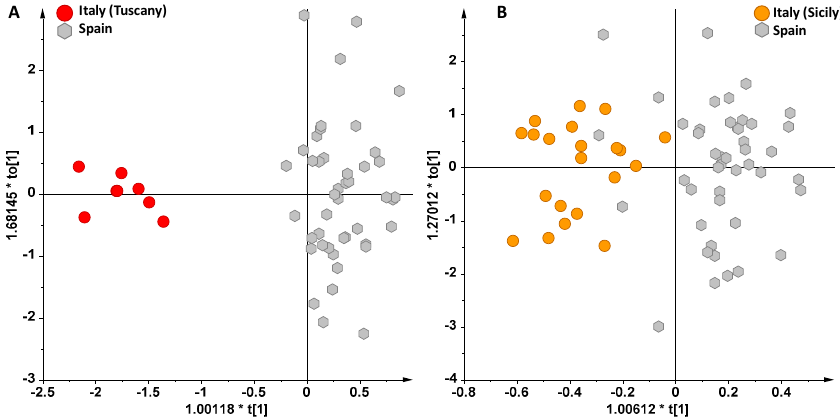
Figure 5. ( A ) OPLS-DA scoreplot for Italian (from Arezzo province, Tuscany region) and Spanish oils (1 + 4 + 0 components gave R2X = 0.91, R2Y = 0.89 and Q2 = 0.84). ( B ) OPLS-DA scoreplot for Italian (from Sicily region) and Spanish oils (1 + 6 + 0 components gave R2X = 0.9, R2Y = 0.71 and Q2 = 0.41).